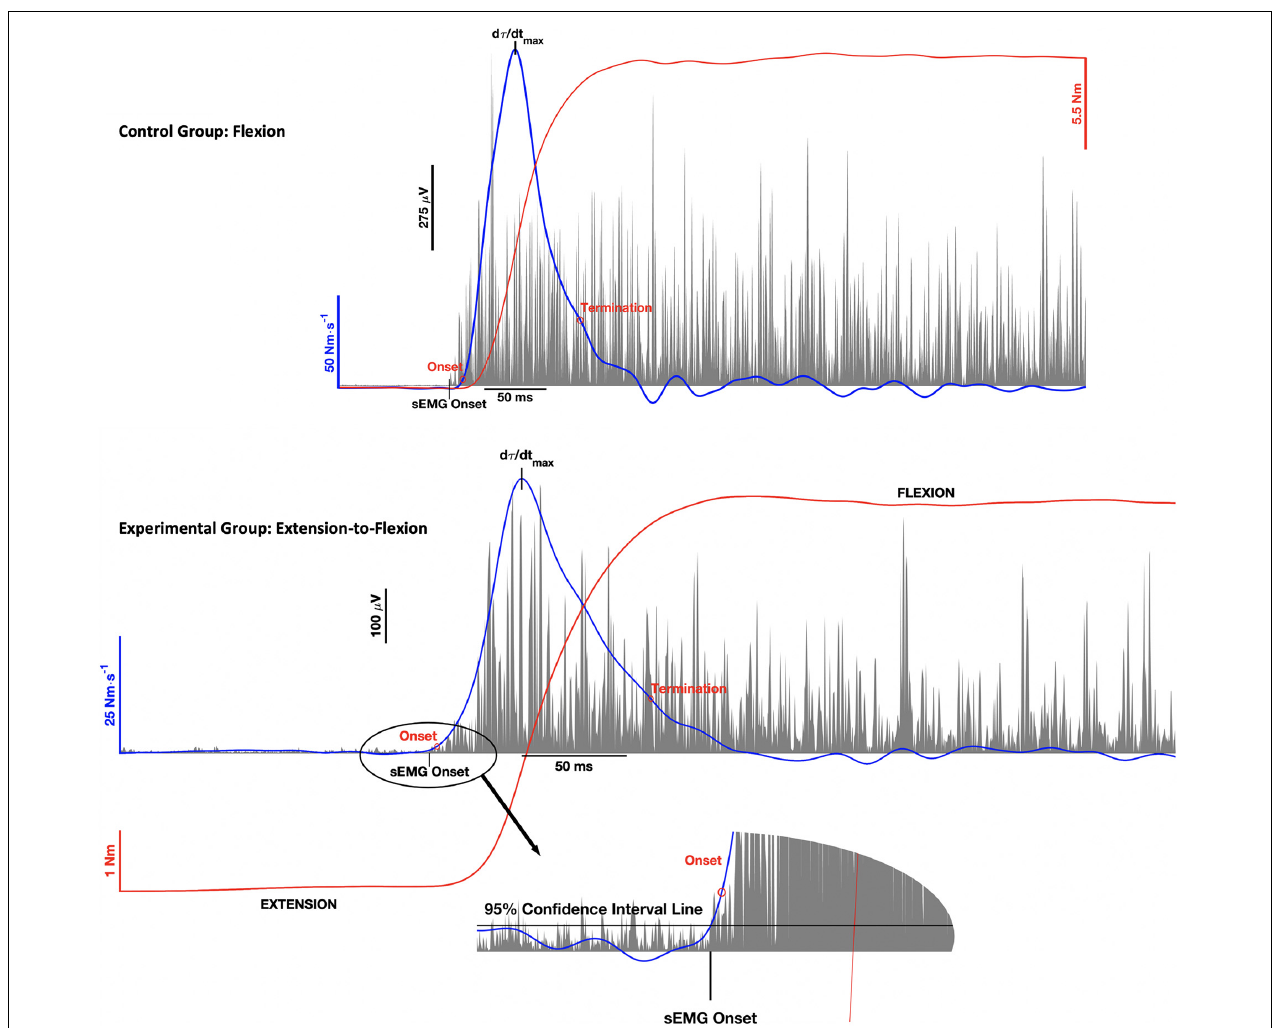
FIGURE 2 | Representative wrist torque (red), rate of torque (blue), and surface electromyographic (sEMG) activity (gray) for the control group (top panel) and experimental group (bottom panel). The graphs illustrate the onset and termination of the torque ( τ ) development phase of the contraction, where the maximum rate of torque development ( d τ / dt max ) was the peak of the curve between these two points. The double threshold algorithm used to detect sEMG onset was the same for both the control and experimental groups. The figure inset associated with the bottom panel illustrates how the algorithm was applied to the PNF contraction